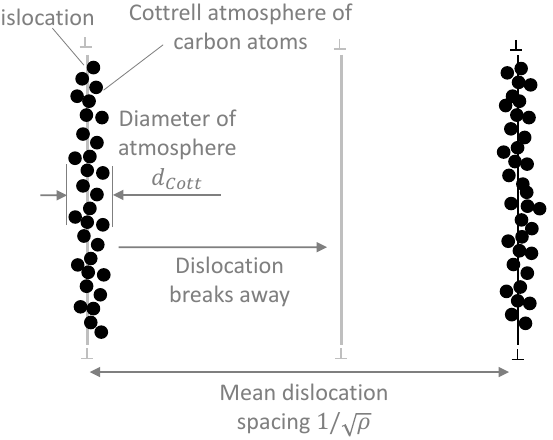
Figure 2. Schematic illustration of dislocation interaction with carbon